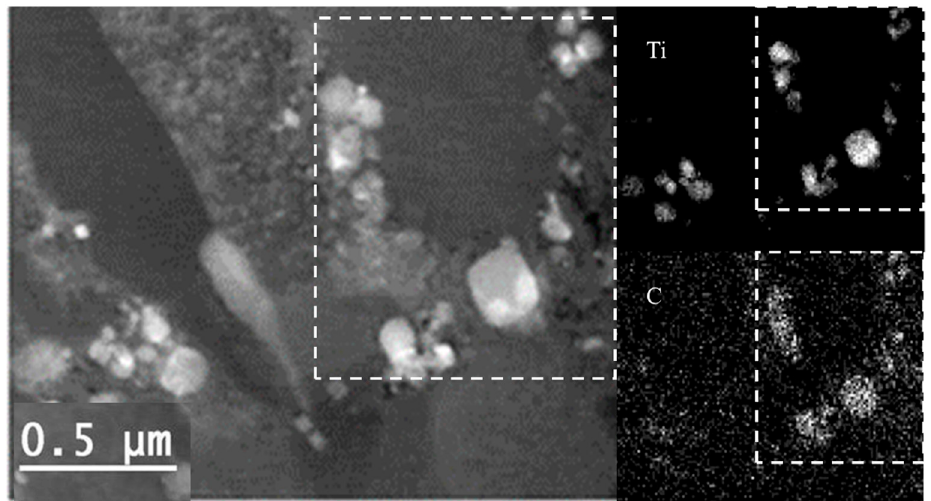
Figure 3. STEM image of the microstructure of AlMNC profiles and EDS elemental mapping analysis.